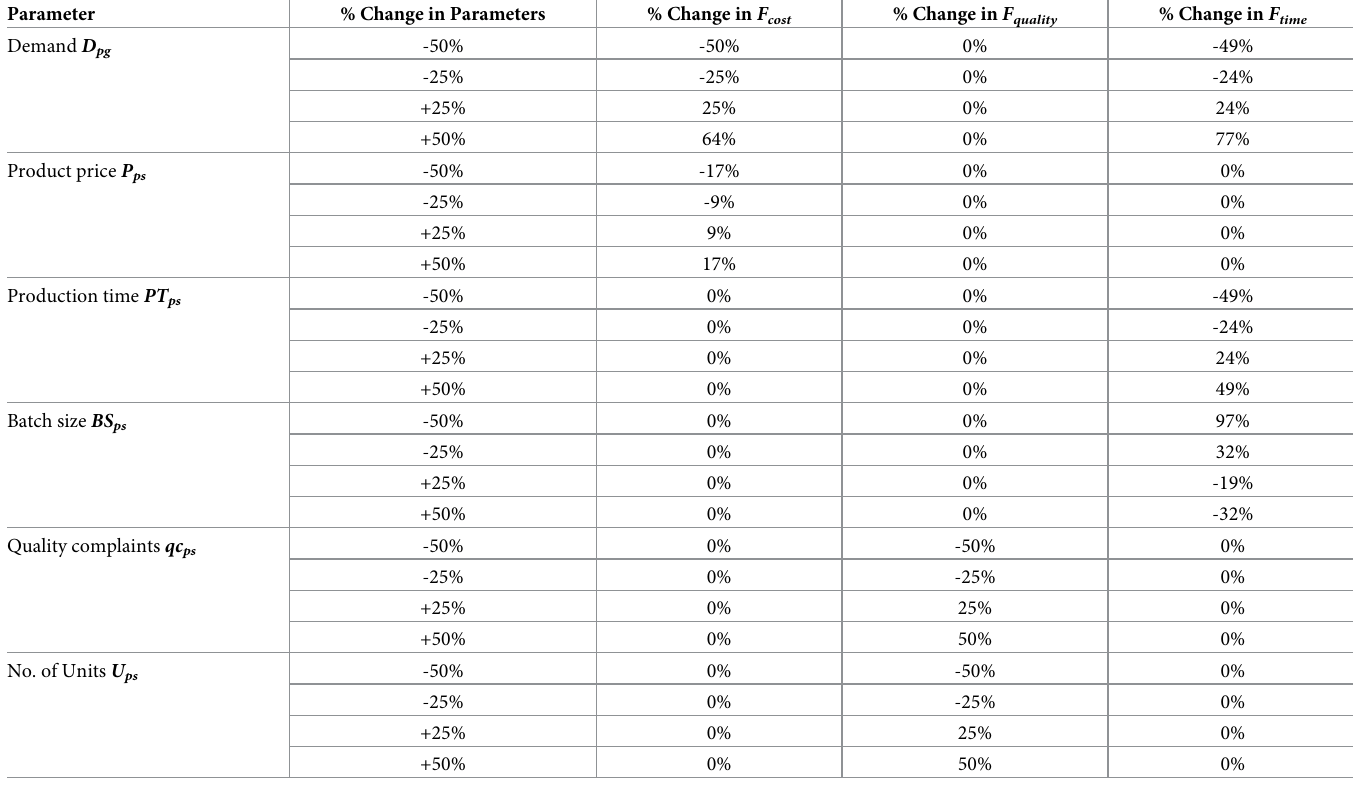
Table 20. Sensitivity analysis on MODM